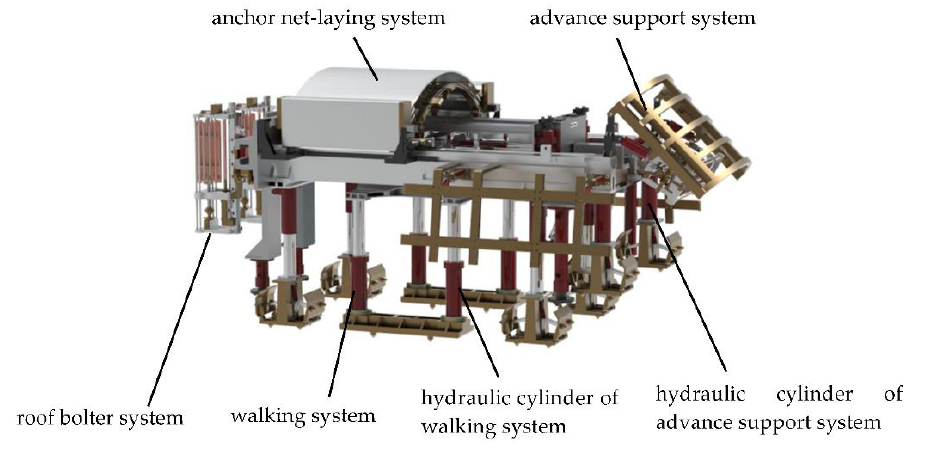
Figure 1. Stepping-type anchoring equipment.